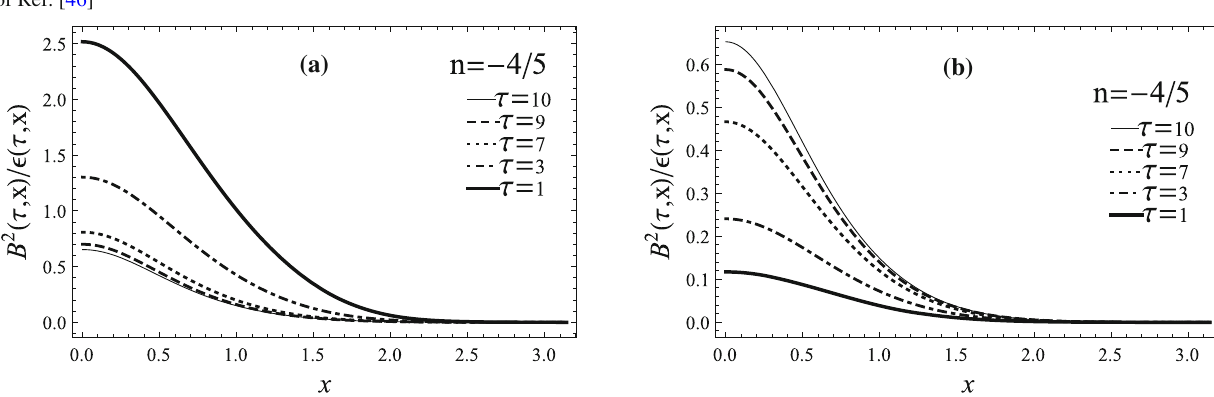
Fig. 13 Transverse velocity v(τ, x ) versus x plotted at different times for n = − 4 / 5, a numerical solutions (present work), b analytical solutions of Ref. [46]